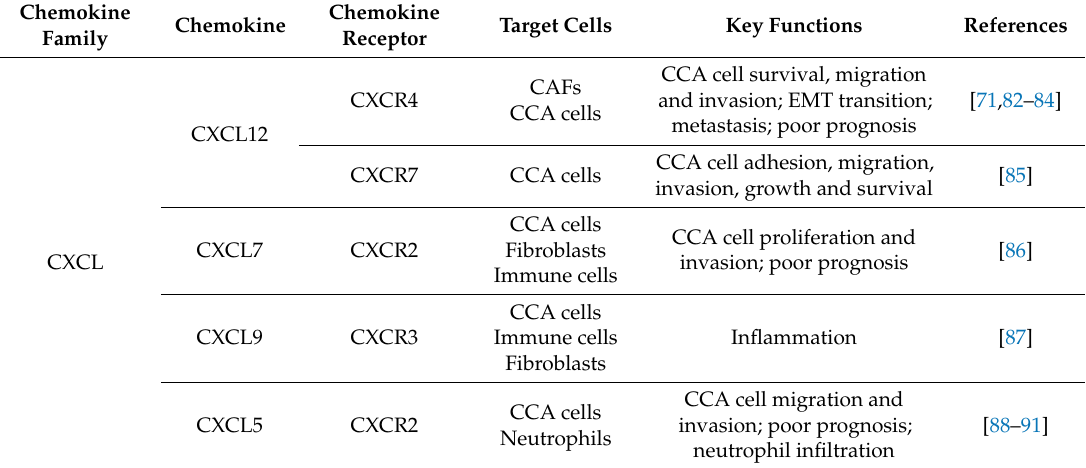
Table 1. Major chemokines and their receptors involved in CCA